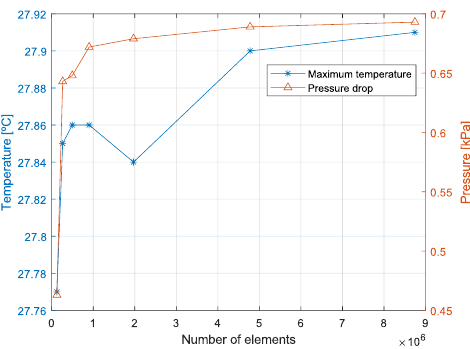
Figure 5. Mesh independence analysis with the maximum temperature of the battery cell (°C) and pressure drop (kPa).